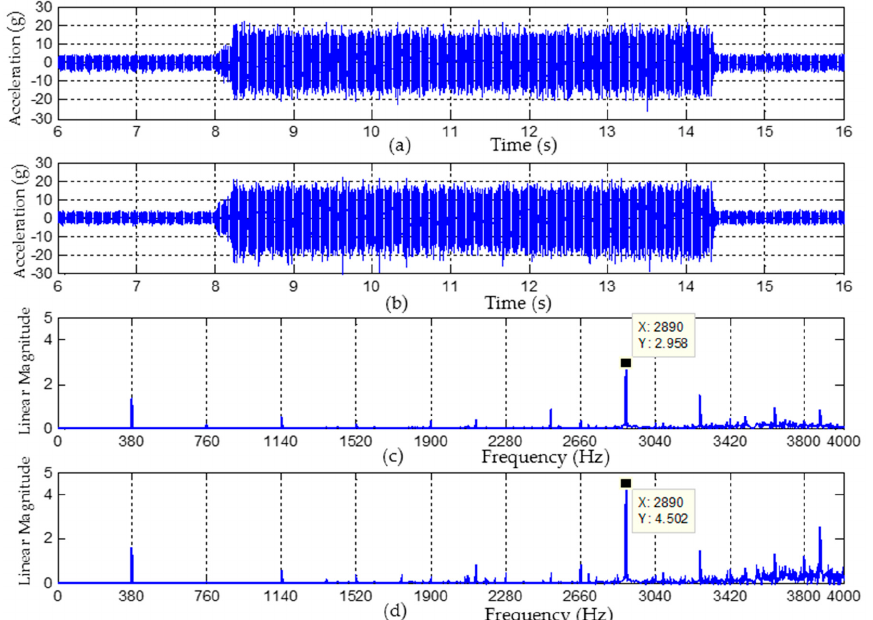
Figure 10. The results of chatter cutting process by using PZT and MEMS accelerometers. ( a ) Time domain response of PZT type; ( b ) Time domain response of MEMS type; ( c ) Frequency response of PZT type ( ■ : the main chatter frequency); ( d ) Frequency response of MEMS type ( ■ : the main chatter